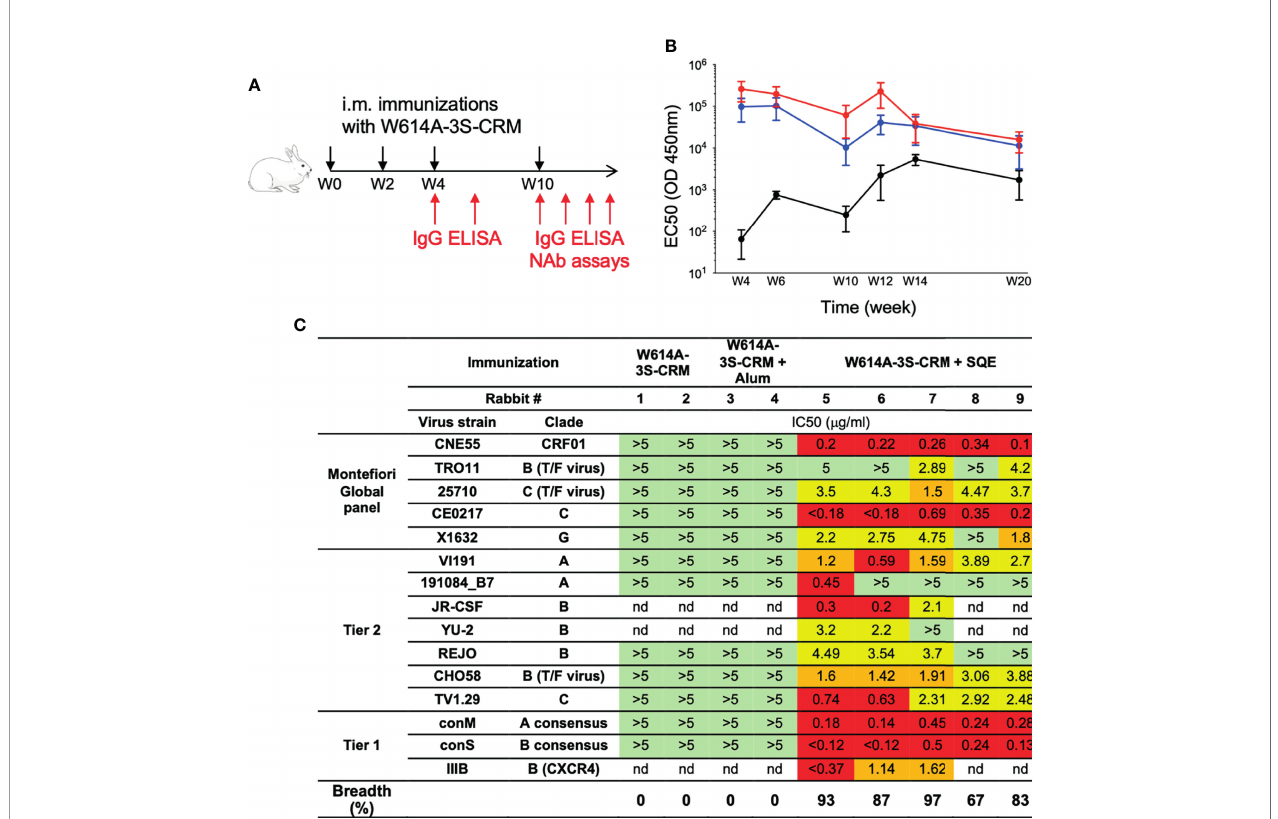
FIGURE 1 | Broad neutralizing Ab induction after squalene emulsion-adjuvanted W614A-3S peptide vaccination. (A) Experimental schedule of rabbit immunizations and biologic samples. Animals were vaccinated at Week 0 (W0), W2, W4, and W10 (black arrows), and blood samples were collected at W4, W6, W10, W12, W14, and W20 (red arrows). (B) Rabbits were immunized with W614A-3S-CRM197 carrier non-adjuvanted (n = 4), adjuvanted with aluminum hydroxide (Alum) (n = 5), or squalene emulsion (SQE) (n = 5). Kinetics of serum W614A-3S-speci fi c IgG of rabbits, immunized with W614A-3S-CRM197 non-adjuvanted (black), or adjuvanted with Alum (blue) or SQE (red). Graph represents EC50 mean ± SEM of OD 450 nm; the y-axis is in log 10 scale. Statistical analyses were performed with two-way ANOVA between two adjuvanted conditions. (C) Serum W614A-3S-speci fi c IgG per condition (n = 2 for non-adjuvanted condition, n = 2 for Alum condition, and n = 5 for SQE condition) were puri fi ed at W20, and neutralizing IC50 were evaluated against different viruses including the Monte fi ori Global panel (16), Tier2, and Tier1. Color codes of neutralization assay (IgG m g/ml): green, >5; yellow, 4.9-2; orange, 1.9-1; and red, <0.9; nd: not done. Breadths represent percentage of total tested HIV strains neutralized by anti-W614A-3S IgG. T/F: transmitted/founder